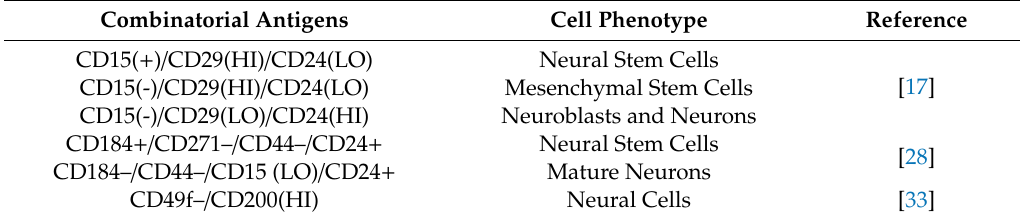
Table 3. Combination of multiple surface markers using cluster of di ff erentiation (CD) antigens. More refined cell type identification can be achieved by a combination of markers, thus excluding partially di ff erentiated cells which may still be able to di ff erentiate aberrantly after